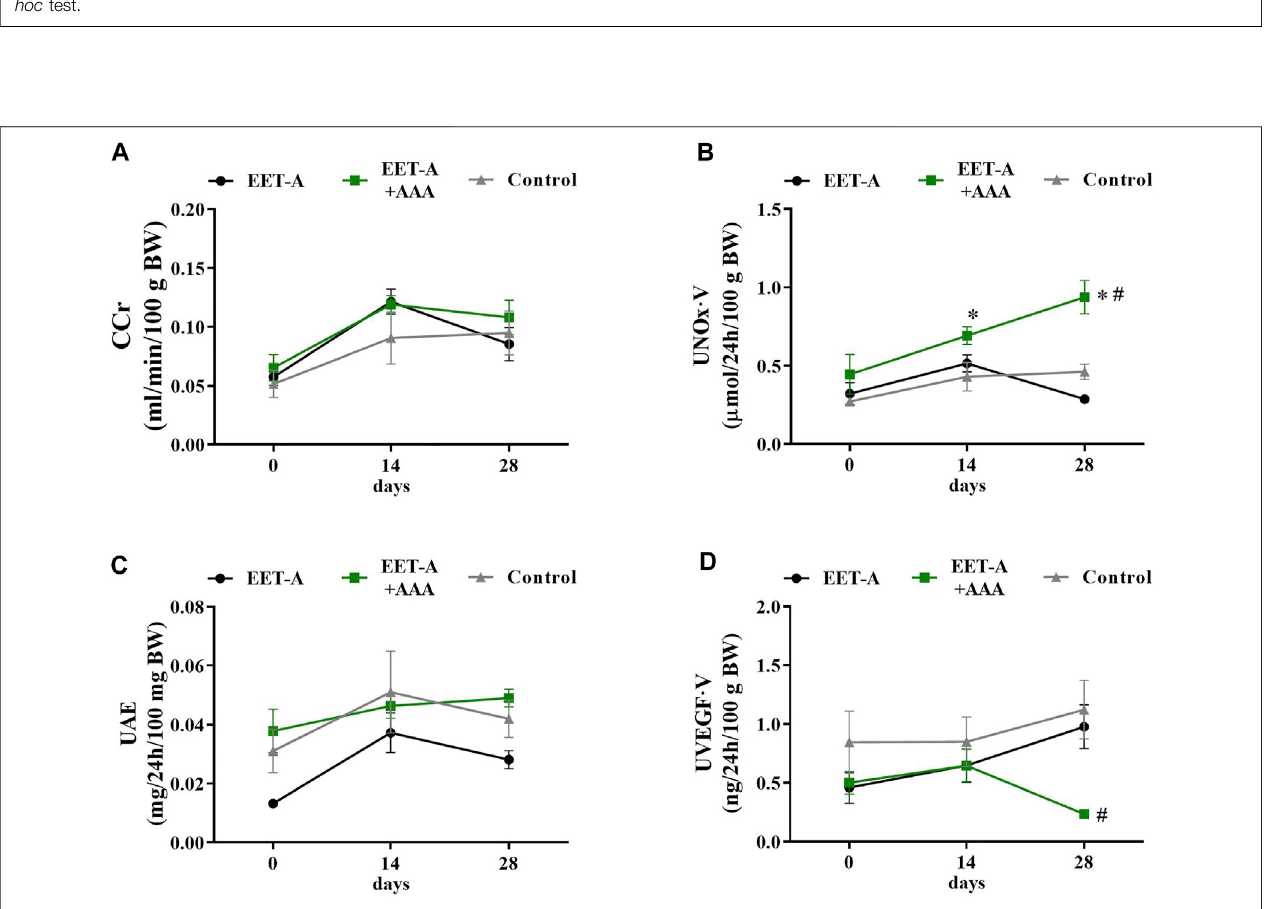
FIGURE 4 |(A) Creatinine clearance, (B) nitric oxide metabolite excretion, (C) urinary excretion of albumin, and (D) urinary excretion of vascular endothelial growth factortypeAmeasuredondays0,14,and28inyoungspontaneouslyhypertensiveratsreceivingepoxyeicosatrienoicacidanalogalone(EET-A, n (cid:1) 7)orcombinedwith 20-HETE receptor antagonist (EET-A + AAA, n (cid:1) 6), both at adose of 10 mg/kg/day; the control group received water ( n (cid:1) 7). * p < 0.05 vs . baselinevalues (day 0) within each group by two-way analysis of variance, followed by Bonferroni ’ s multiple-comparisons test; # p < 0.05 EET-A + AAA vs . EET-A and the control group at the same time point by two-way analysis of variance, followed by Tukey ’ s post-hoc test.